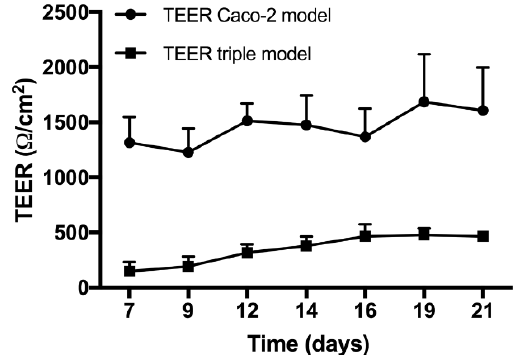
Figure 6. Transepithelial electrical resistance (TEER) values (Ω/cm 2 ) monitored in function of time during the 21 days of culture on Transwell™ membranes for Caco-2 monoculture model and Caco-2/HT29-MTX:Raji B triple co-culture model.